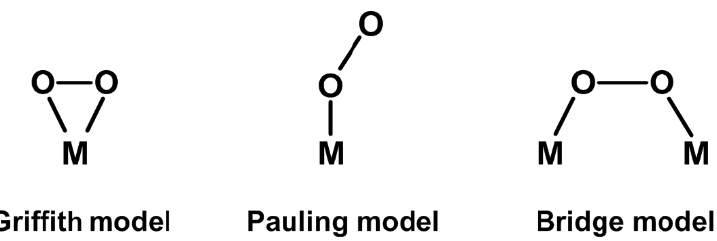
Figure 9. Suggested models for the adsorption of the oxygen molecule onto a metal catalyst (M) surface.